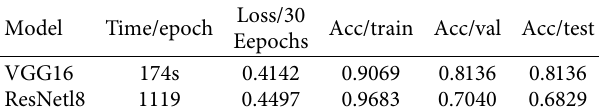
Figure 5: VGG and ResNet loss comparison. Table 2: Comparison of